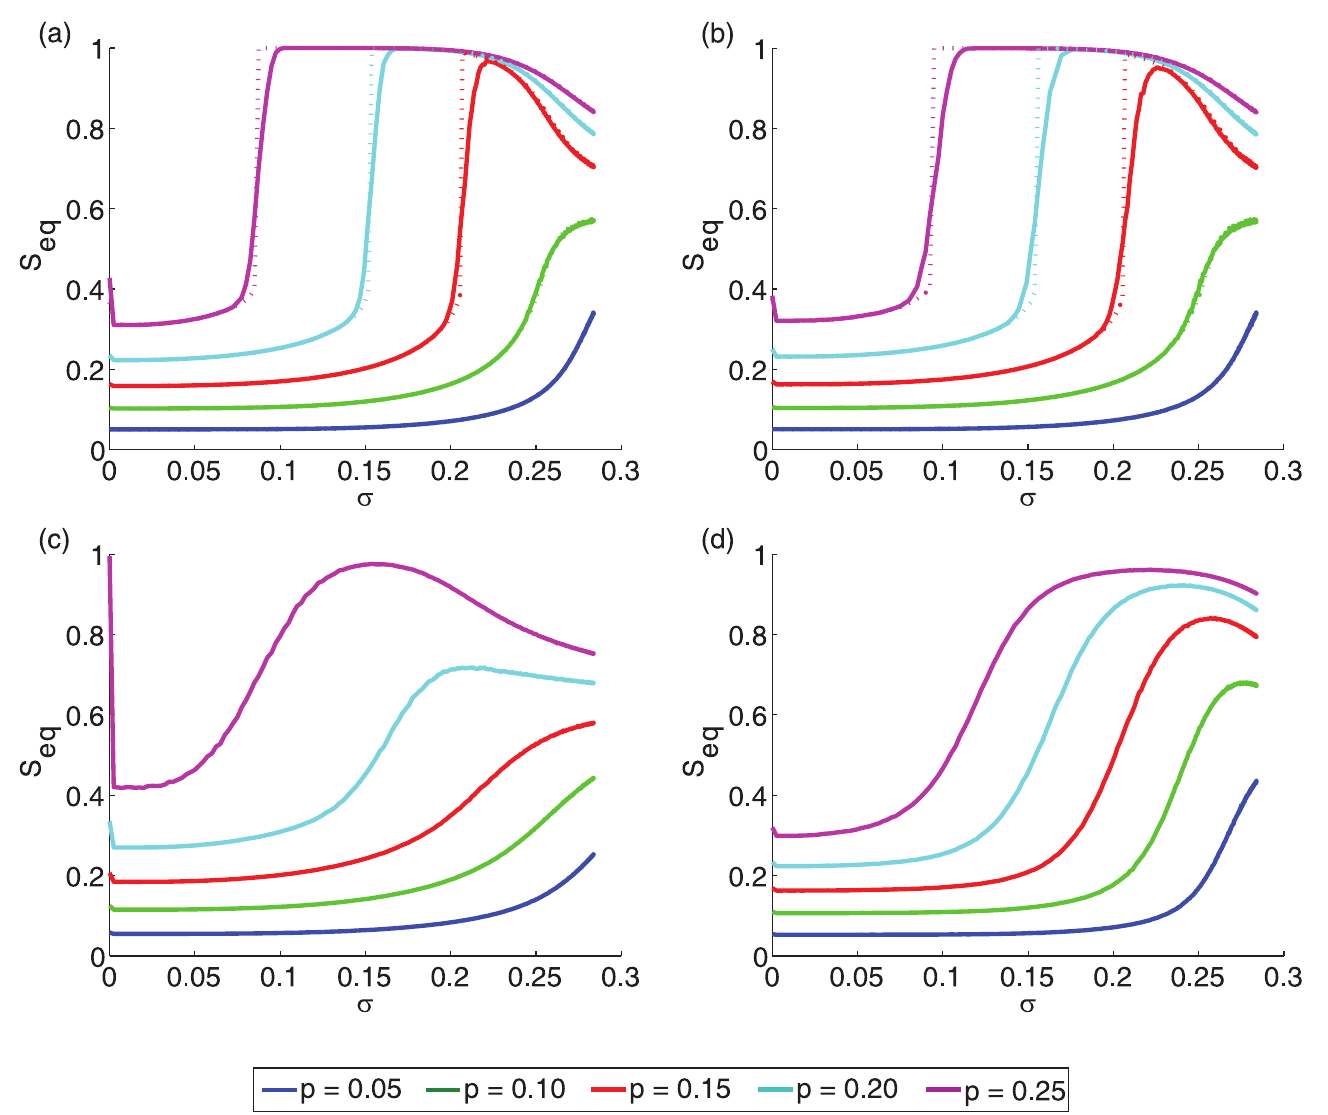
Fig 1. Behavior of the cascade size S eq at equilibrium for varying standard deviation σ . (a) ER graphs with z = 10 and N = 10 4 ; (b) SF networks with z = 10, γ = 3, and N = 10 4 ; (c) high-school network with z = 5.96 and N = 921; (d) facebook network with z = 43 and N = 4039. The mean threshold is ϕ The simulations are averaged over one thousand repetitions. (a) and (b) also show the analytic estimates (dotted lines) based on the tree-like approximation (see Materials and Methods) [14].